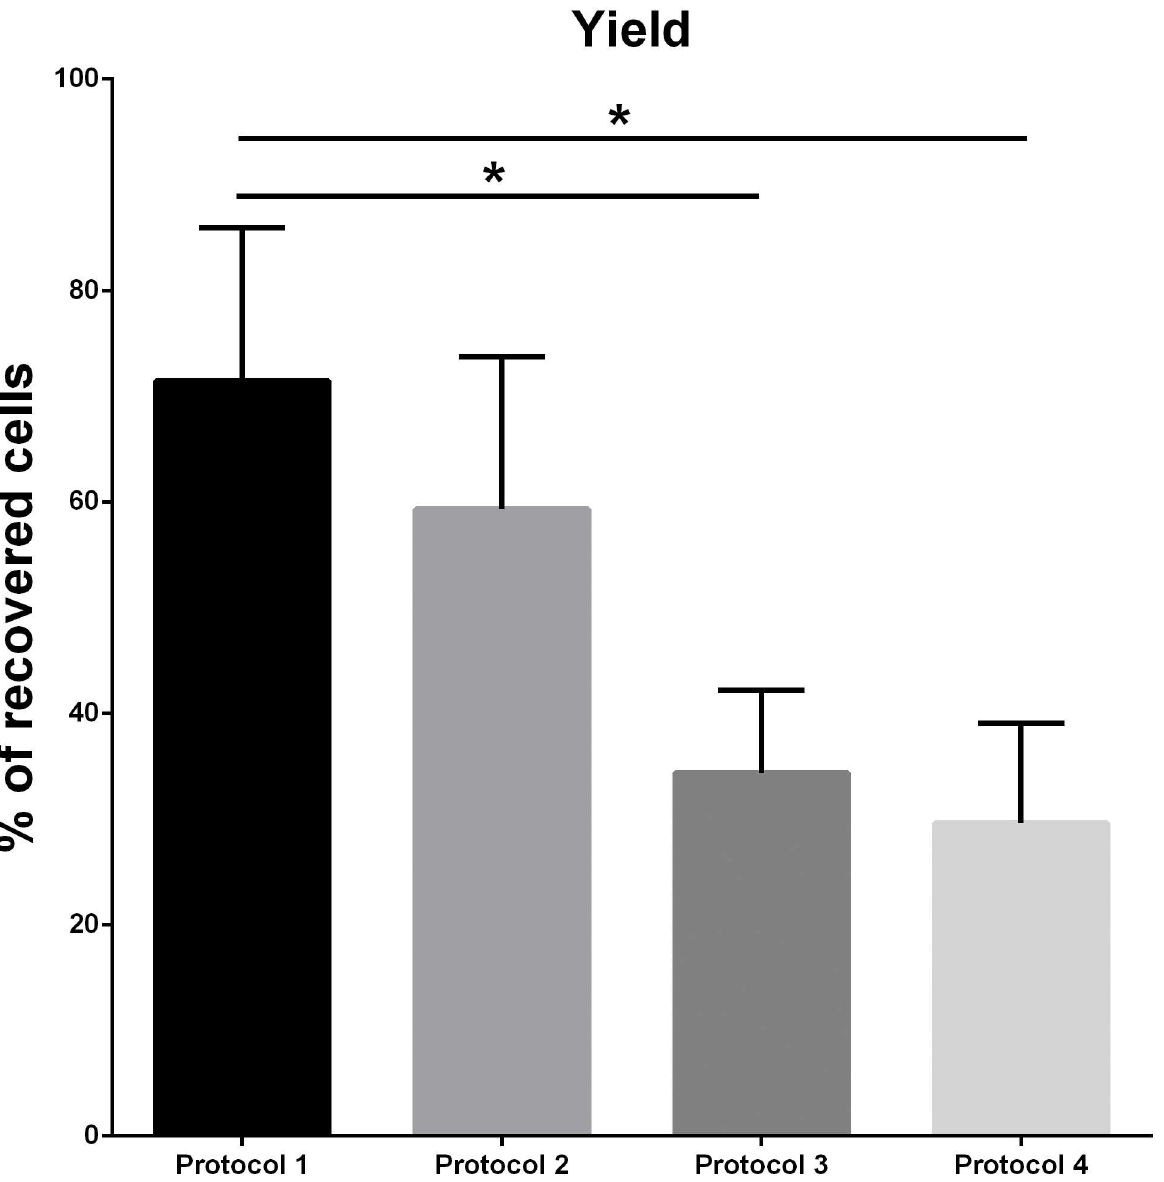
Fig 2. Cell recovery yield after cryopreservation. Representation of the retrieved cell percentage for each cryopreservation protocol immediately after thawing.Values expressedas mean + SEM (n = 5). Statistical analysis: One-way ANOVA with Tukey’s multiple comparison post-hoc test ( * = p <